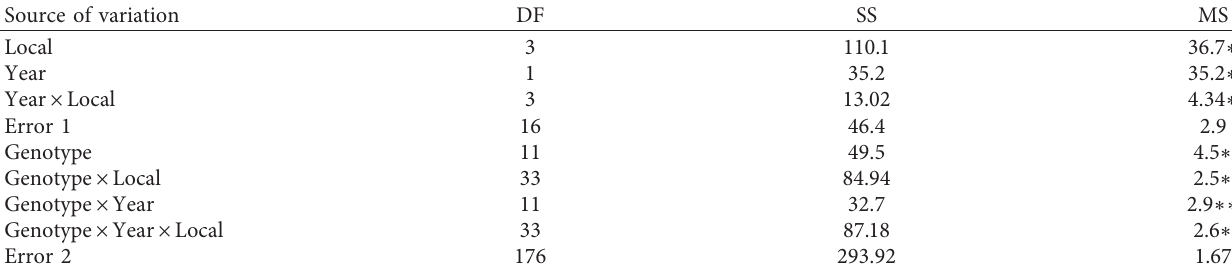
Table 3: Combined analysis of variance for maize hybrid in four environments and two years.